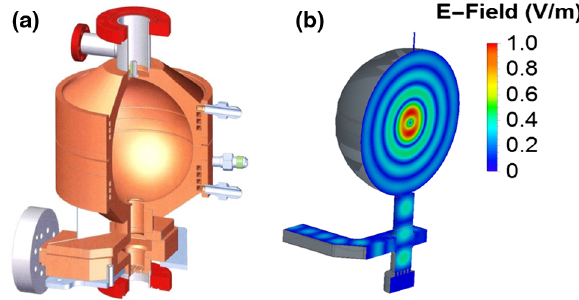
FIG. 9. (a) Cutaway CAD drawing of the spherical cavity used for pulse compression with RF polarizer, and (b) contour plot TE 141 mode in the spherical cavity calculated